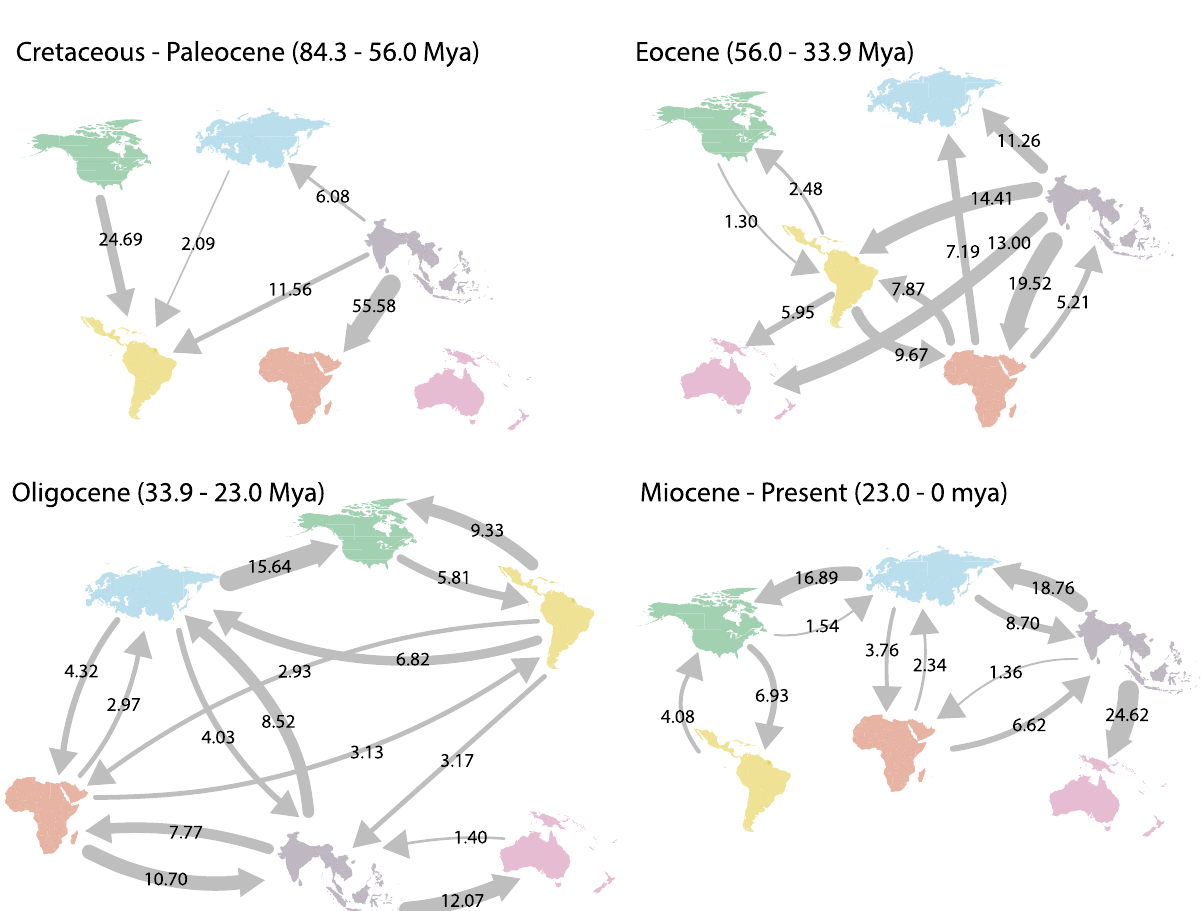
Fig. 2 Percentages of dispersal events between regions as inferred by our DECX analysis through different geological periods. Arrows indicate the direction of dispersal and numbers denote the percentage of the total number of events during each period of time. All events representing less than 1% are not